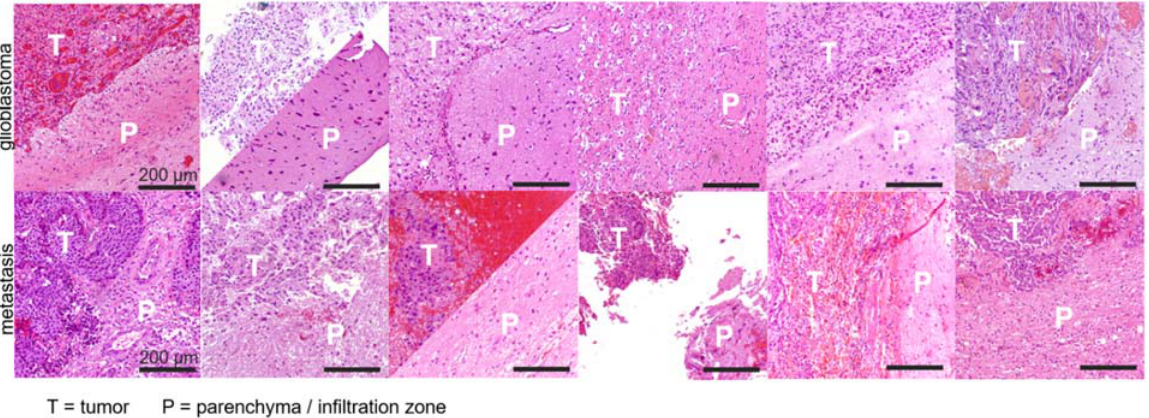
Figure 7. Exemplary histopathological sections in 6 patients with IDHwt GBM ( upper row ) and 6 patients with metastases ( lower row ). In each case, tumor area (T) and surrounding/infiltrating area (P) are obliquely juxtaposed. Metastases show an increased loosening of the surrounding immediate peritumoral tissue (see also Figure 6) in all cases by visual comparison with GBM. This image impression refers to the immediate peritumoral region. In some cases, the assessability was limited by the retrospective evaluation of surgery ‐ related fragmented tissue. Magnification bars indicate 200 μ m.